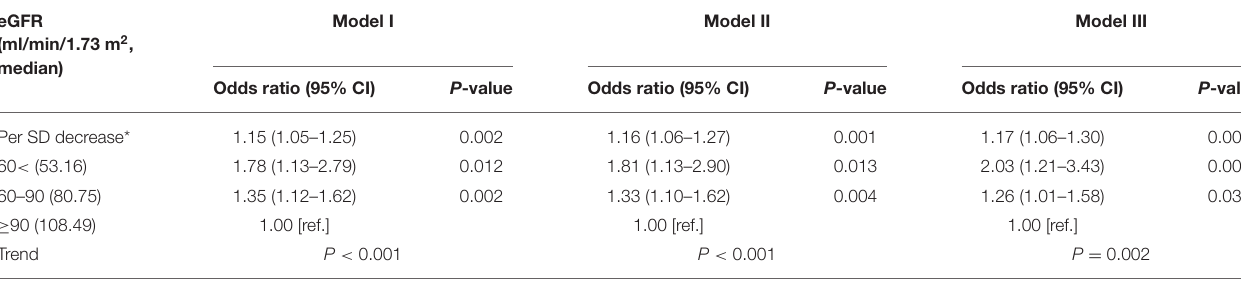
TABLE 3 | Odds ratios (95% CI) for eGFR, calculated by C-MDRD equation, in relation with low HDL-C. eGFR (ml/min/1.73 m 2